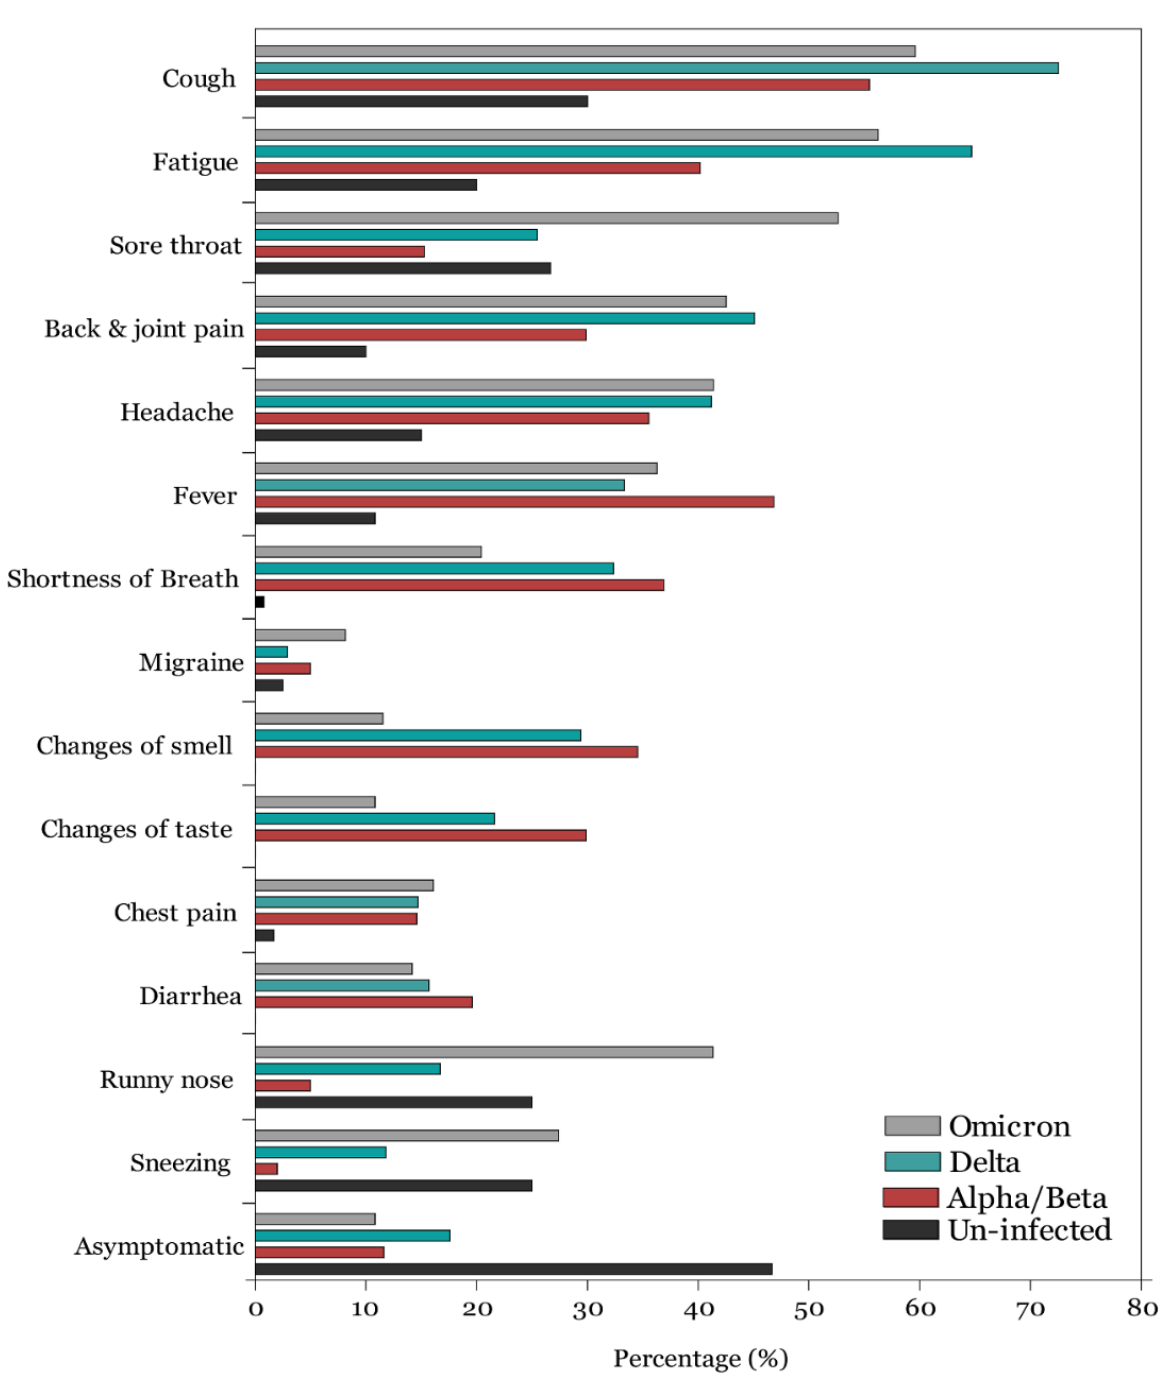
Figure 1. Frequency of COVID-19 symptoms among uninfected and infected participants when alpha/beta, delta, and omicron COVID-19 variants were dominant.